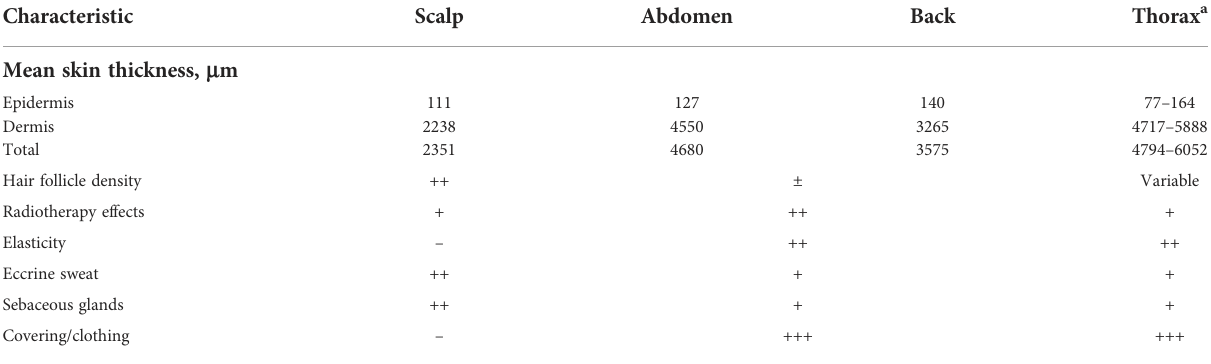
TABLE 2 Skin characteristics by body